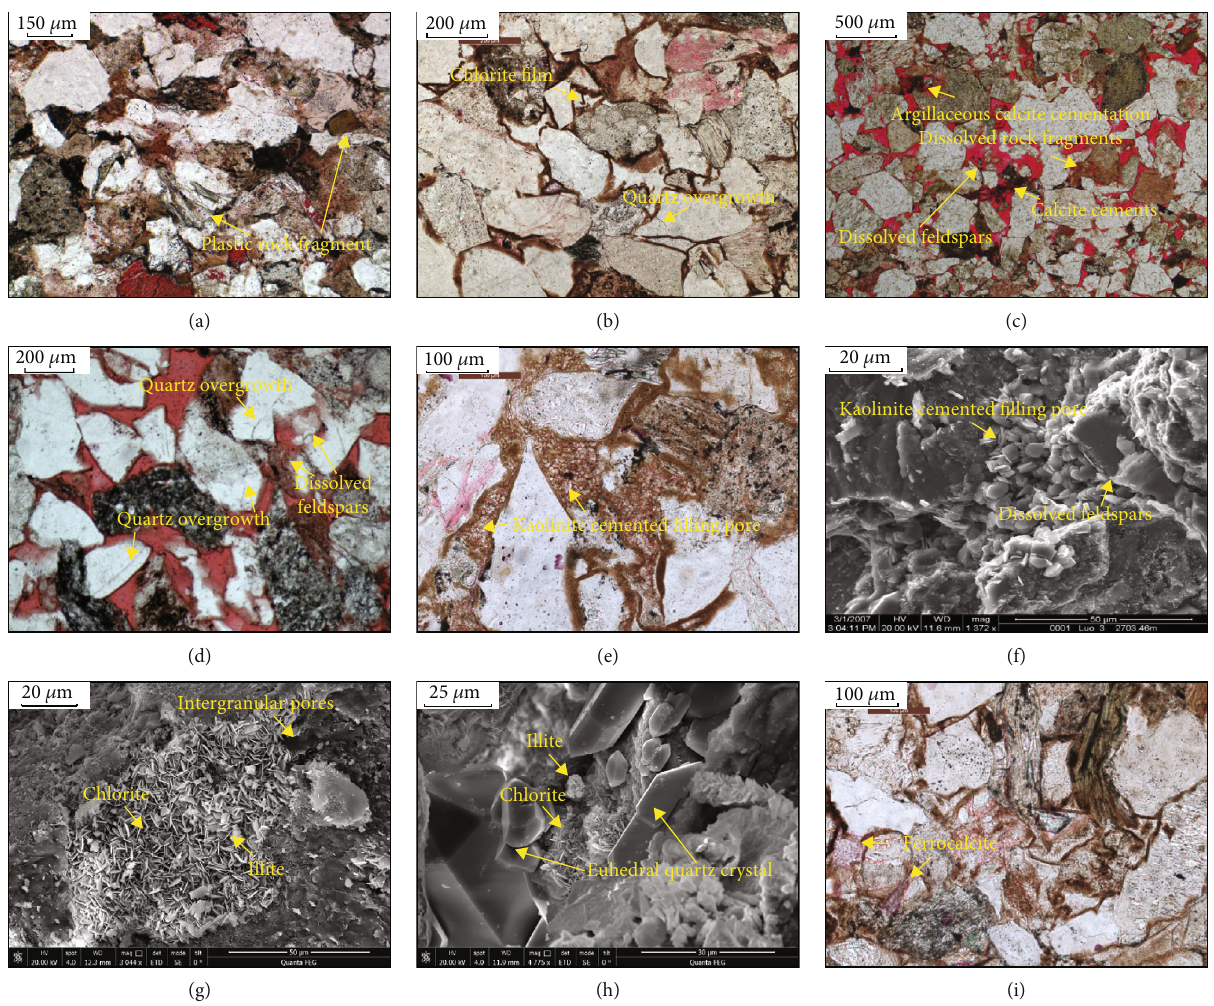
Figure 10: Factors for the identi fi cation of a typical diagenetic sequence. Thin section photomicrographs and SEM images show the following: (a) YPA: compaction results in the tight fi tting of particles and compression of cuttings; (b) APA: chlorite fi lm developed earlier than quartz overgrowths; (c) APA: in the early stage of calcite cementation development, the grains were mainly in point contact, and a chlorite coating existed around the grains; (d) APA: quartz overgrowths occurred earlier than the dissolution of feldspar and rock fragments; (e) APA: feldspar and rock fragments are dissolved and fi lled with kaolinite; (f) YPA: when kaolinite fi lls the dissolution pores, illite and chlorite have not yet been fi lled; (g) APA: the pores are fi lled with chlorite and a small amount of illite; (h) APA: euhedral quartz fi lls in later than chlorite and illite; and (i) APA: late ferrocalcite cementation. Table 8: Four types of diagenetic facies classi fi cation function coe ffi